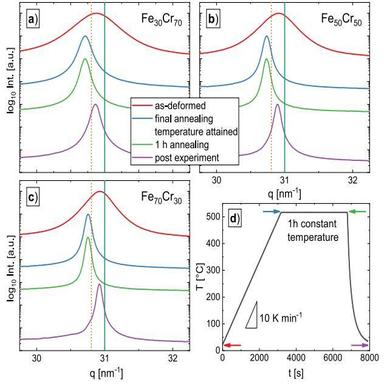
HEXRD synchrotron data of the peak for HPT-deformed FeCr samples consisting of a) Fe30Cr70, b) Fe50Cr50 and c) Fe70Cr30. Vertical lines denote theoretical reference lines for Fe (solid, turquoise) and Cr (dashed, brown). The selected patterns belong to in situ annealing experiments and are extracted at different times and temperatures, visualized d) by arrows in an exemplarily temperature profile.